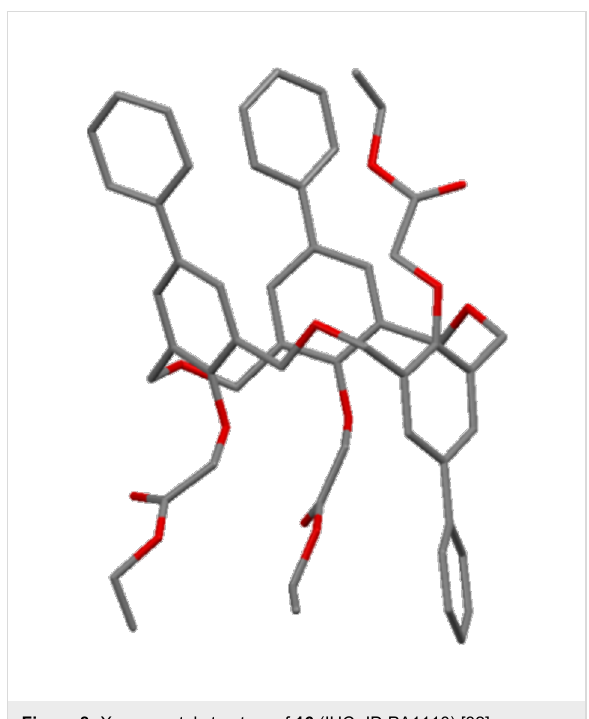
Figure 8: X-ray crystal structure of 16 (IUCr ID PA1110) [32].